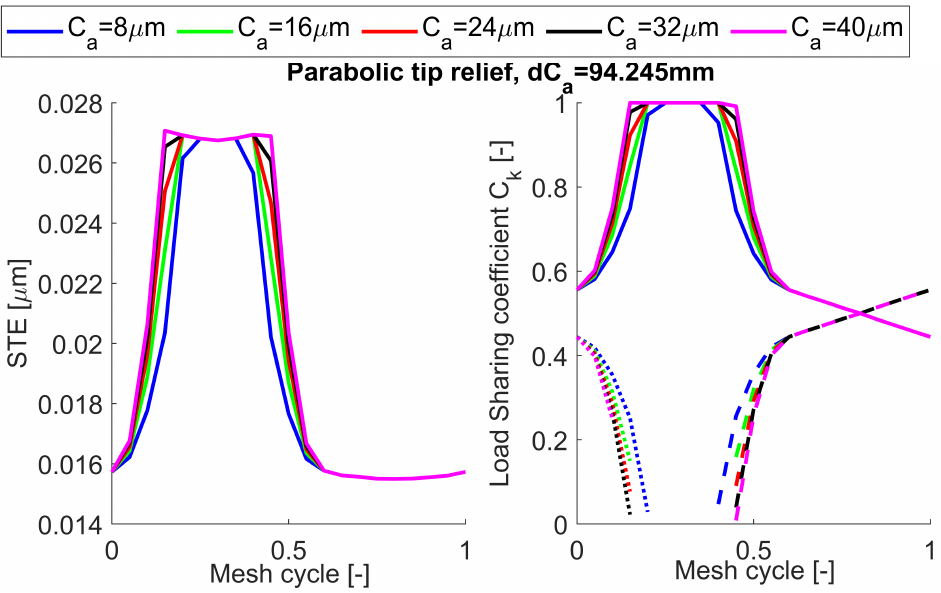
Figure 19. Effect of parabolic tip relief amount of material removed on the STE and load sharing.